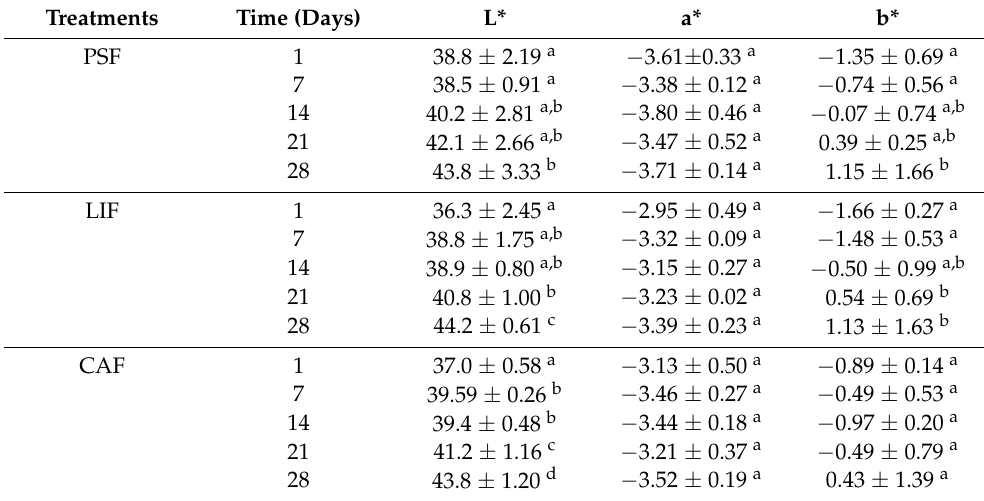
Table 1. The effects of different freezing treatments on the color of largemouth bass during frozen